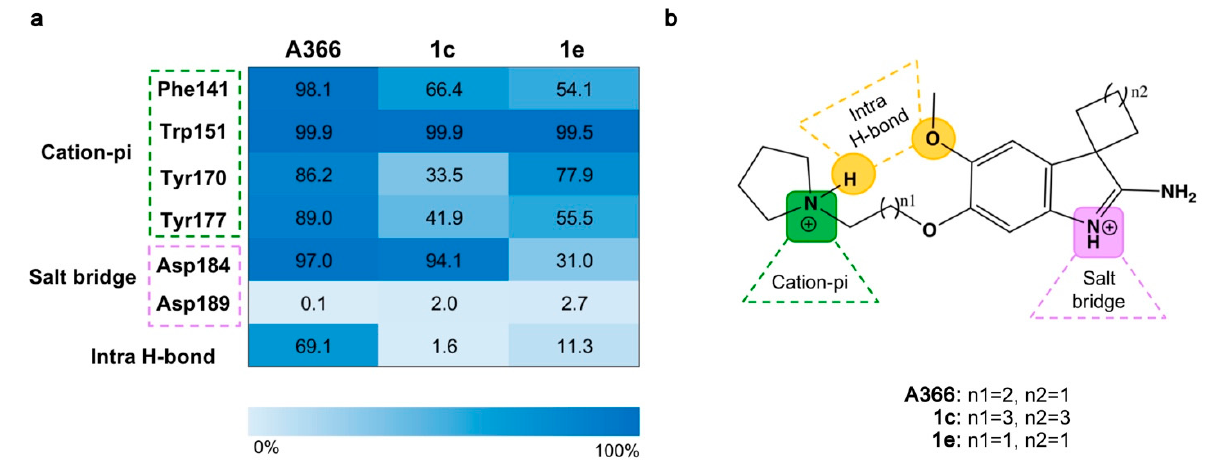
Figure 5. Summary of the binding interactions identified during 200 ns MD simulations of the reference ligand A366 and the inactive compounds 1c and 1e . The binding poses were obtained from docking into Spindlin1 second domain binding site (PDB ID: 6I8Y). ( a ) Heat map showing the occupancy rates of the observed interactions. ( b ) Common structure of the compounds highlighting the atoms involved in the interactions.